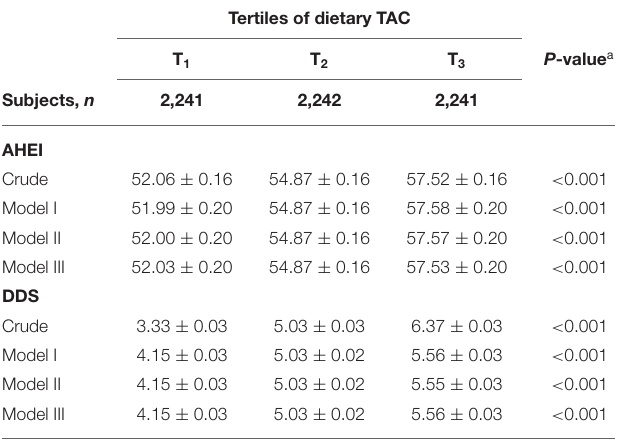
TABLE 2 | Mean scores of AHEI and DDS across tertiles of dietary TAC. Tertiles of dietary TAC